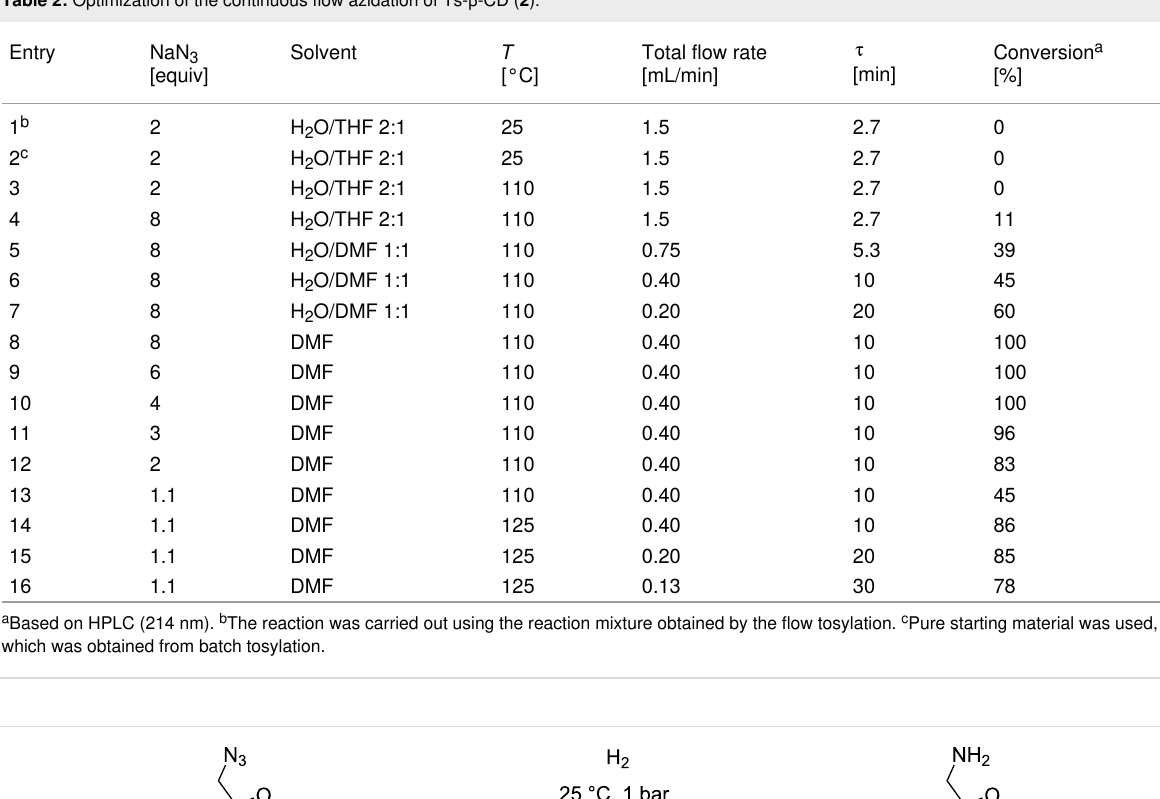
Table 2: Optimization of the continuous flow azidation of Ts- β -CD ( 2 ).